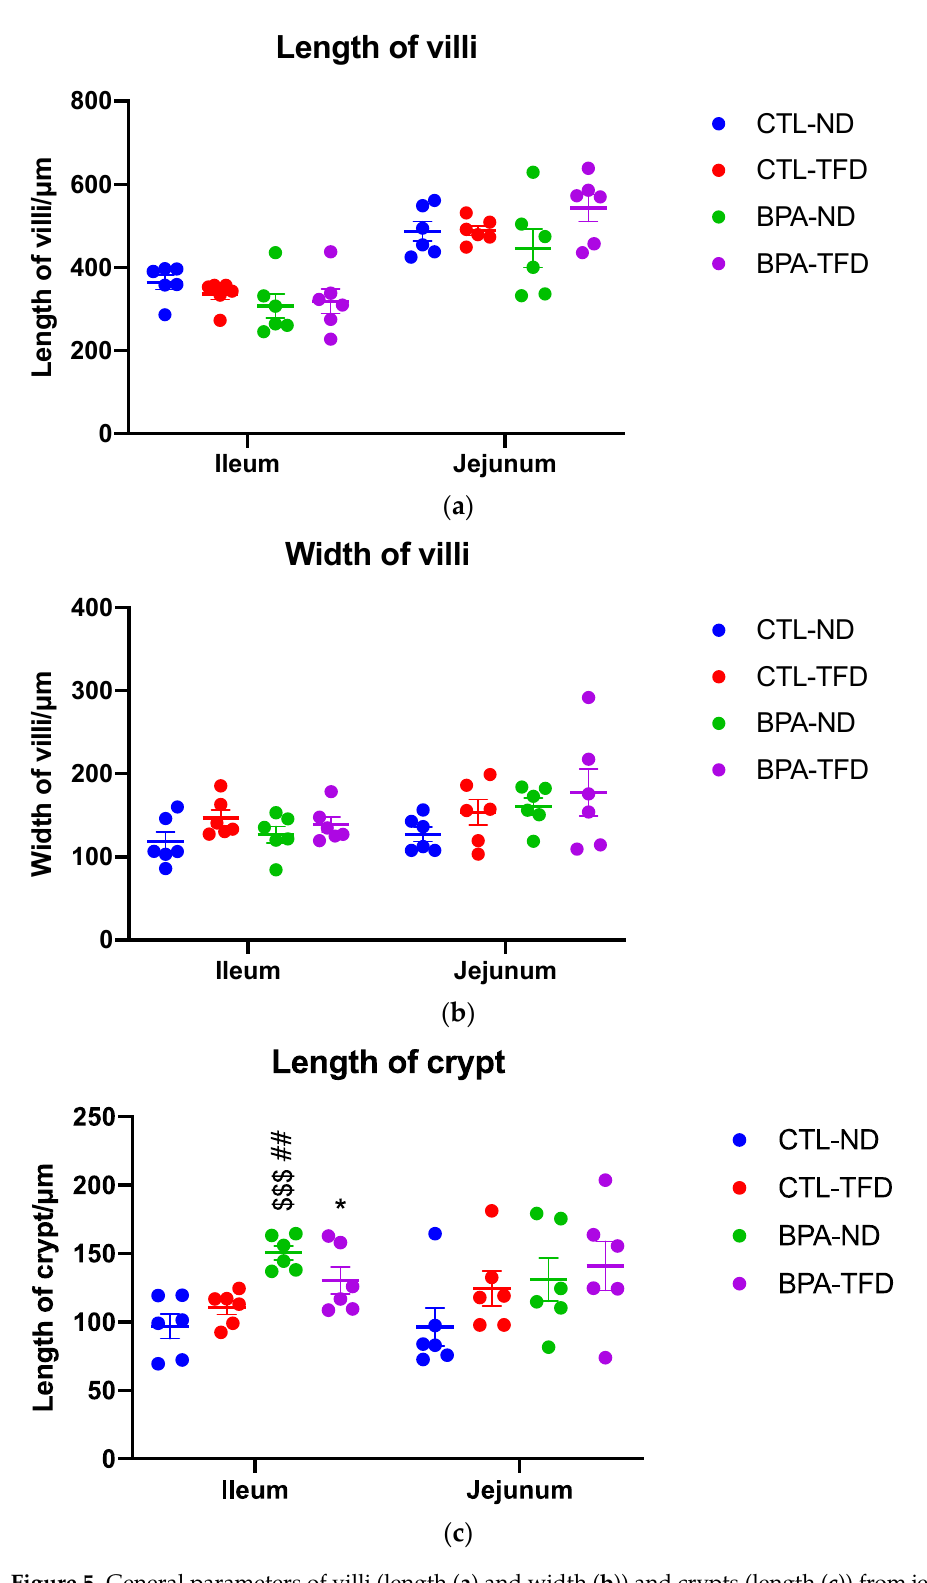
Figure 5. General parameters of villi (length ( a ) and width ( b )) and crypts (length ( c )) from jejunum and ileum sections of adult offspring. These parameters were quantitated using Image J software version 1.53a. Each dot indicates individual samples, and data are shown as means ± SEM (* p < 0.05 CTL-ND vs. BPA-TFD, ## p < 0.01 CTL-TFD vs. BPA-ND, $$$ p < 0.001 CTL-ND vs. BPA-ND; n = 6/group).